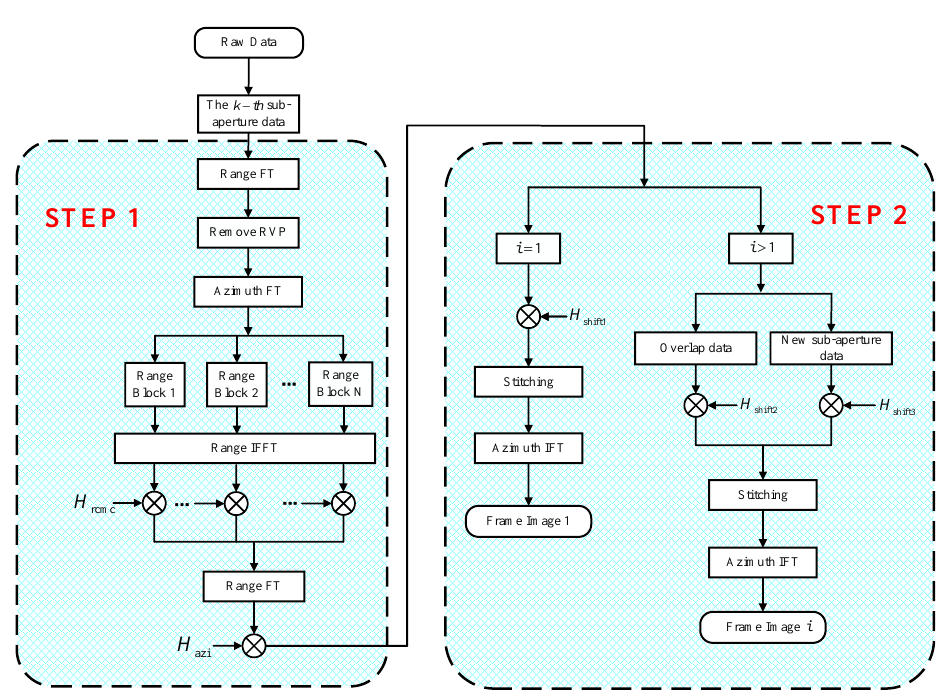
Figure 8. Flowchart of the proposed method.